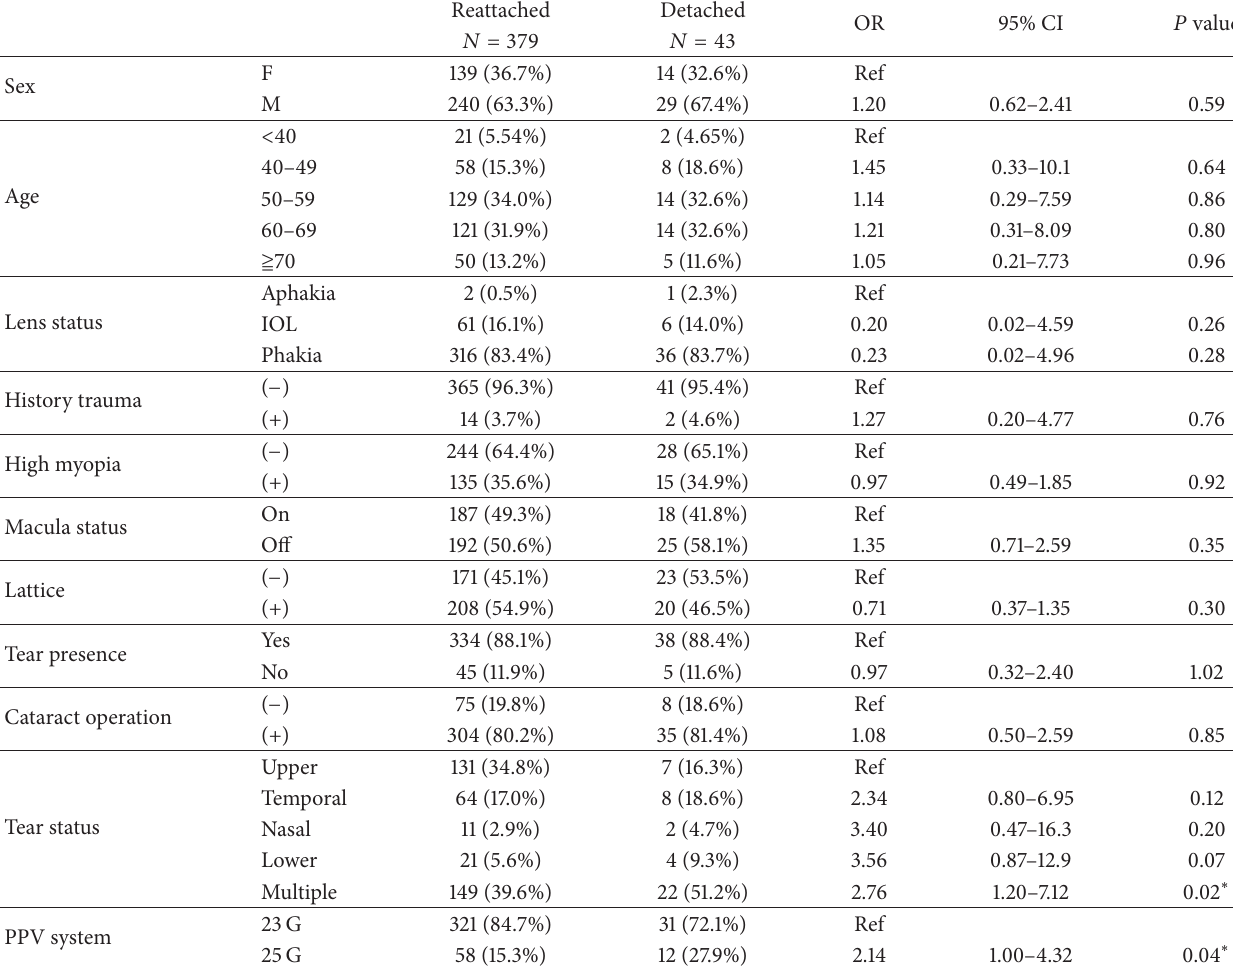
Table 3: Univariate logistic regression analysis of possible risk factors for primary anatomical failure.